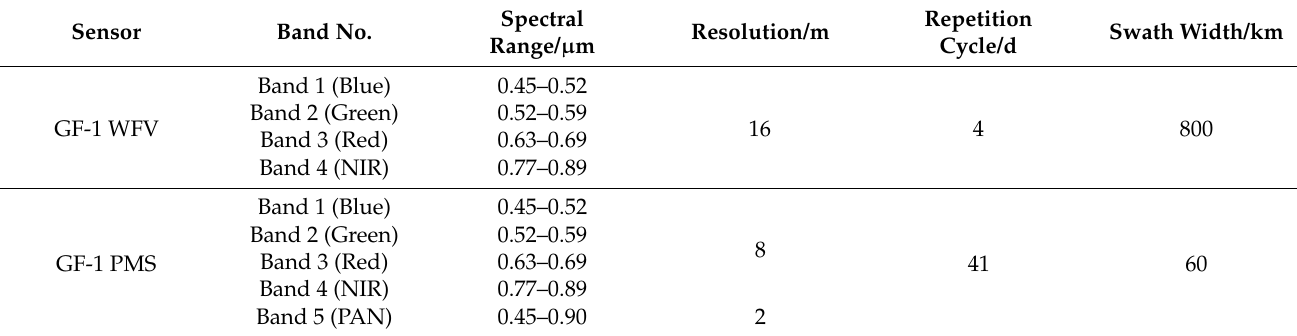
Table 1. Introduction of GF-1 WFV and PMS sensor parameters.